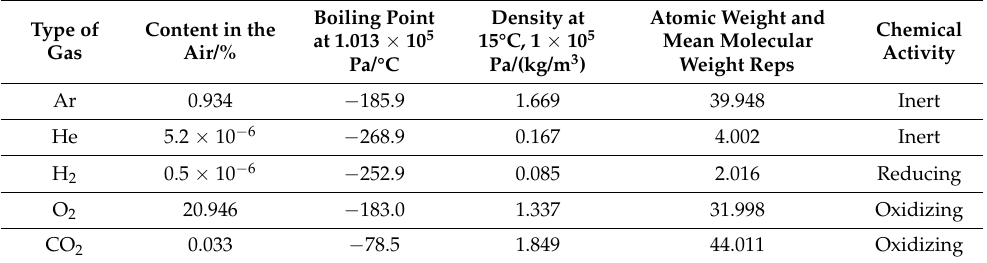
Table 4. Basic chemical and physical properties of the gases commonly used in